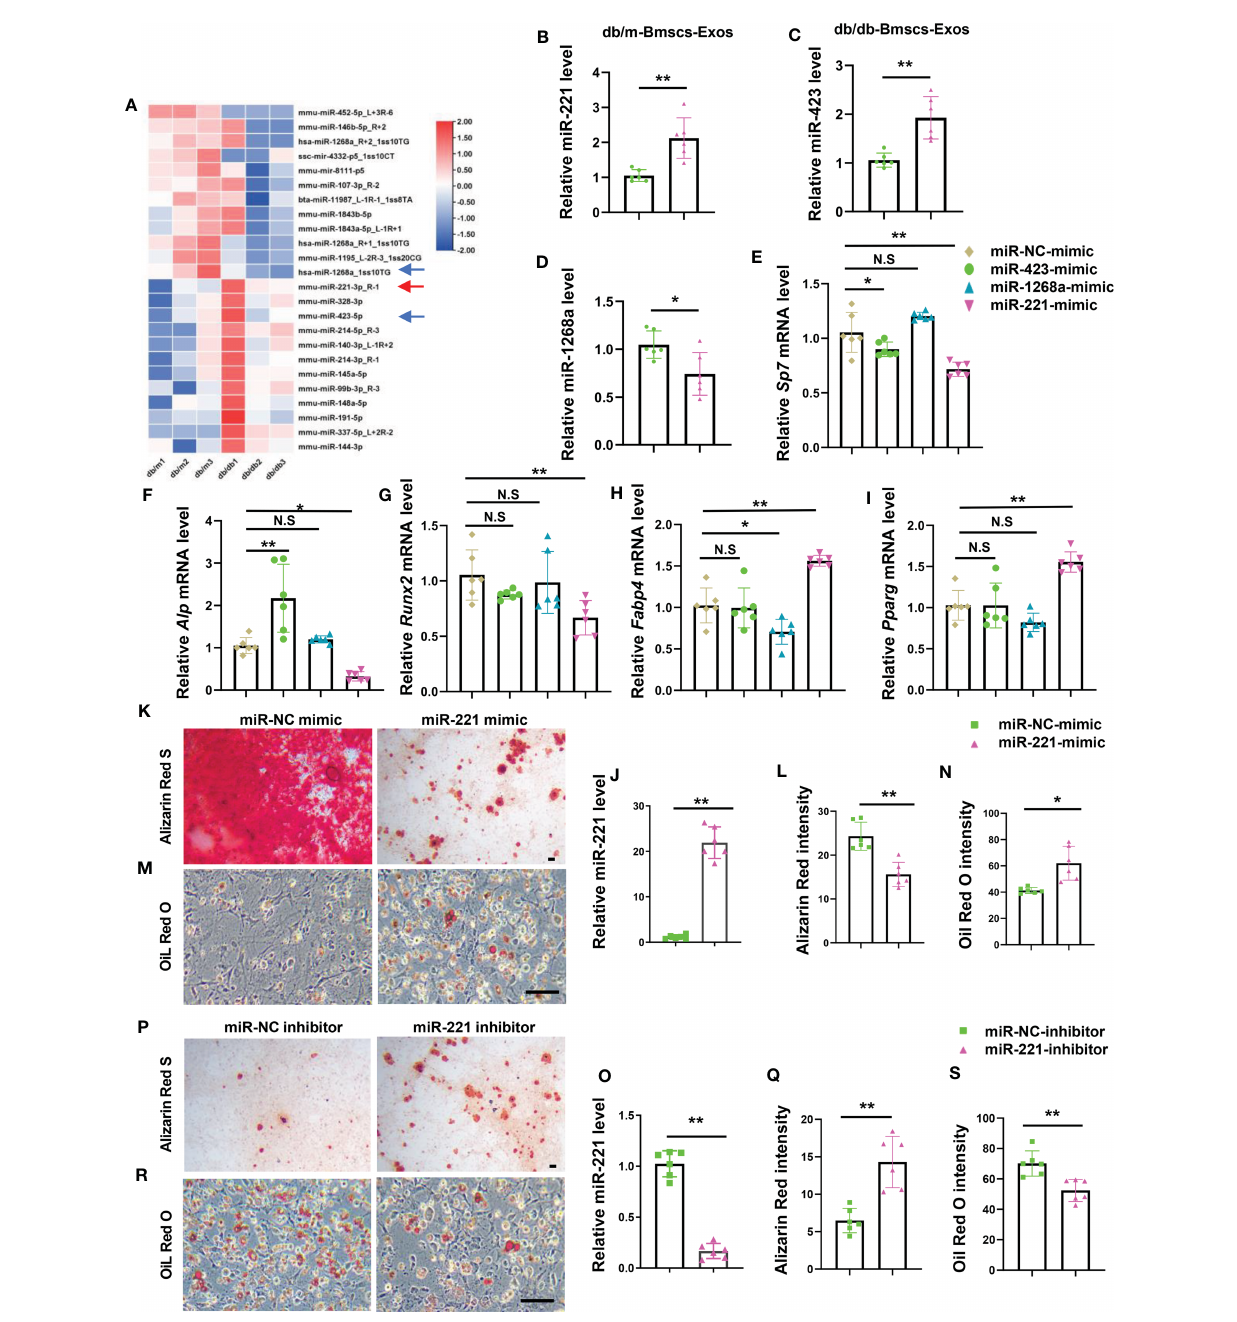
FIGURE 3 Diabetic BMSCs derived exosomal miR-221 suppresses osteogenesis and enhances adipogenesis. (A) Microarray analysis of deregulated miRNAs in normal and diabetic mice BMSCs Exosomes, n=3 per group. (B-D) qRT-PCR analysis of the expression of miR-221 (B) , miR-423 (C) , and miR-1268a (D) in BMSCs Exosomes derived from normal and diabetic mice, n=6 per group. (E-I) Over-express miR-221, miR-423, and miR-1268a in BMSCs from wild type mice in C57 BL/6J background for 6 hours, respectively, then culture them in osteogenic induction medium and adipogenic induction medium for 3 days. Relative mRNA expression level of osteogenesis-related genes Sp7 , Alp and Runx2 , respectively (E-G) ; mRNA expression levels of adipogenic gene, Fabp4 and Pparg , respectively (H, I) ; NC, normal control, n=6 per group. (J-N) Transfected miR-221 mimic into BMSCs for 6 hours, then culture them in osteogenic induction medium for 21 days and adipogenic induction medium for 8 days. miRNA expression levels of miR-221 (J) ; representative images of matrix mineralized ash (K) , Scale bar: 100 m M; quanti fi cation of Alizarin Red S staining (L) ; Representative images of lipid droplet (M) , Scale bar: 100 m M; quanti fi cation of Oil Red O staining (N) . NC, normal control, n=6 per group. (O-S) Transfected miR-221 inhibitor into BMSCs for 6 hours, then culture them in osteogenic induction medium and adipogenic induction medium for 14 days. miRNA expression levels of miR-221 (O) ; representative images of matrix mineralized ash (P) , Scale bar: 100 m M; quanti fi cation of Alizarin Red S staining (Q) ; Representative images of lipid droplet (R) , Scale bar: 100 m M; quanti fi cation of Oil Red O staining (S) . NC, normal control, n=6 per group. The data is shown as the mean ± SD. * P <0.05, ** P <0.01, Welch ’ s t test is used in (B, C) and (M) , Student ’ s t-test is used in (D, K, O) and (Q) , Kruskal wallis test used in (G) , ANOVA used in others. NS, not signi fi